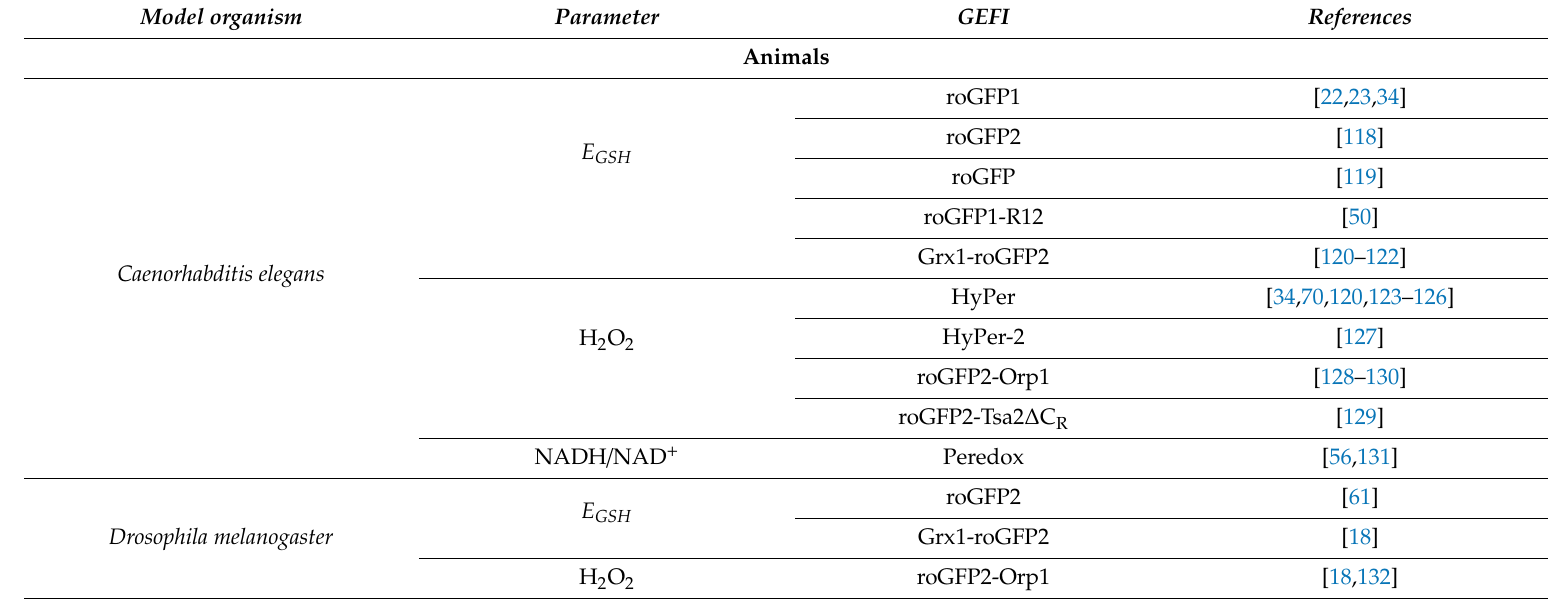
Table 2. Model organisms in which redox GEFIs were